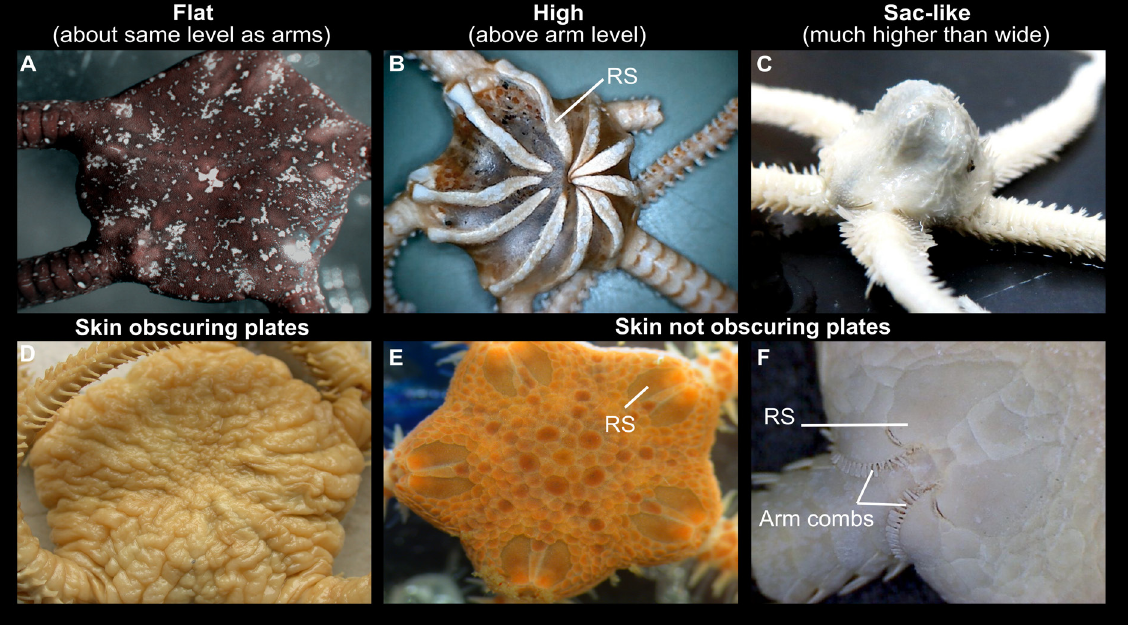
Fig. 1. Dorsal disc shapes and radial shields in brittle stars as defined for the purpose of this study. A . Flat ( Ophioderma sp.). B . High, with bar-like radial shields ( Asteronyx loveni Müller & Troschel, 1842 (dry specimen)). C . Sac-like, radial shields absent ( Ophiotholia spathifer (Lyman, 1879)). D . Thick skin obscuring scales and plates ( Ophiosparte gigas Koehler, 1922). E . Flat, radial shield scalene triangular to half circle ( Amphiura chiajei Forbes, 1843). F . Arm combs, radial shields isosceles triangular to pear- shaped ( Ophiura ophiura (Linnaeus,